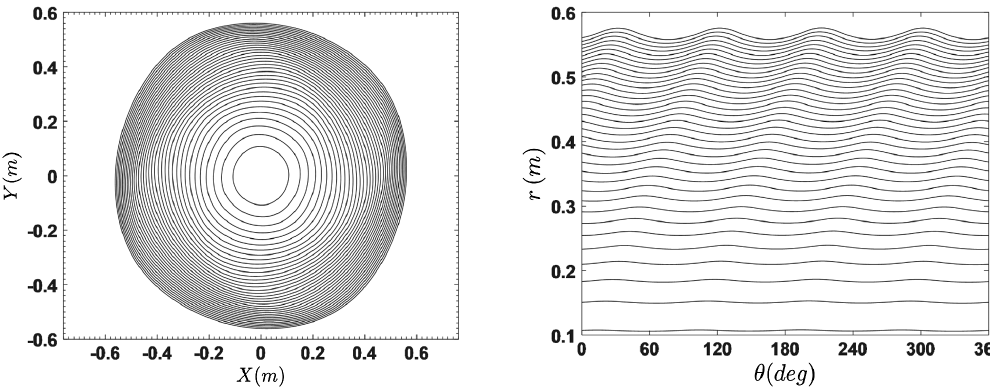
FIG. 9. Equilibrium orbits for the SC200 cyclotron.